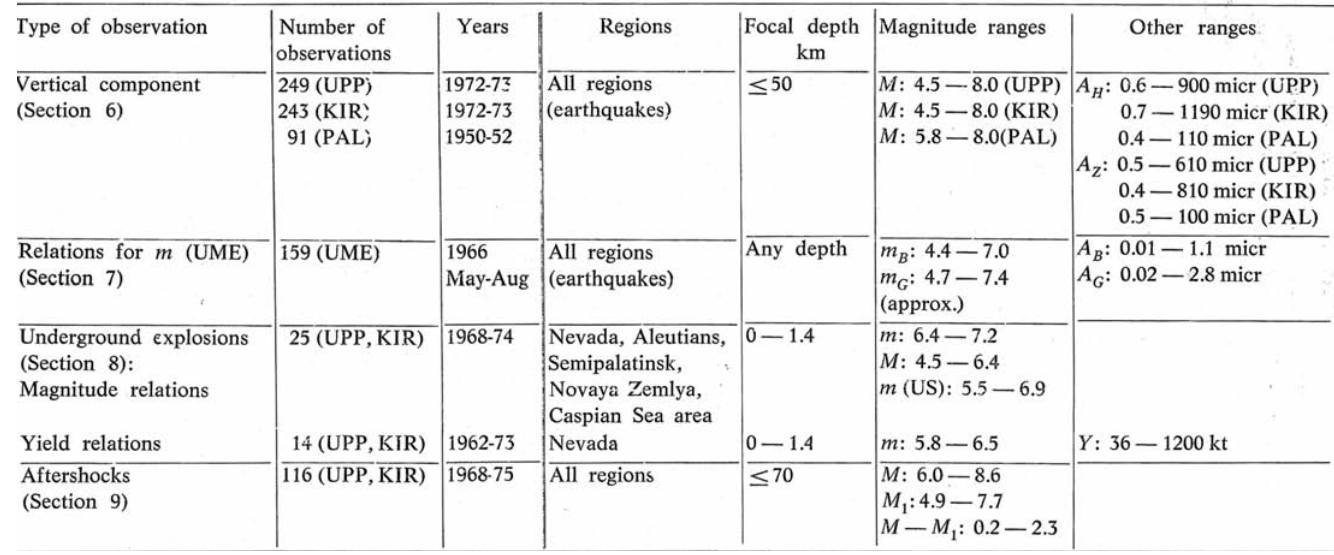
Table 5. Review of observational material for Sections 6 to